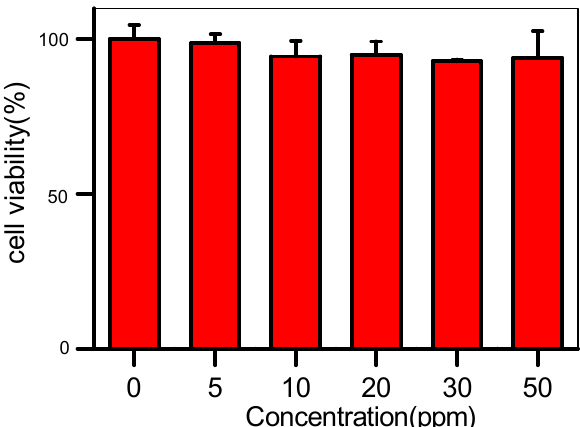
Figure 6. Cell viability of HeLa cells treated with different concentrations of AIE–Fe nanodots (0, 5, 10, 20, 30 and 50 ppm) for 24 h via MTT assay.